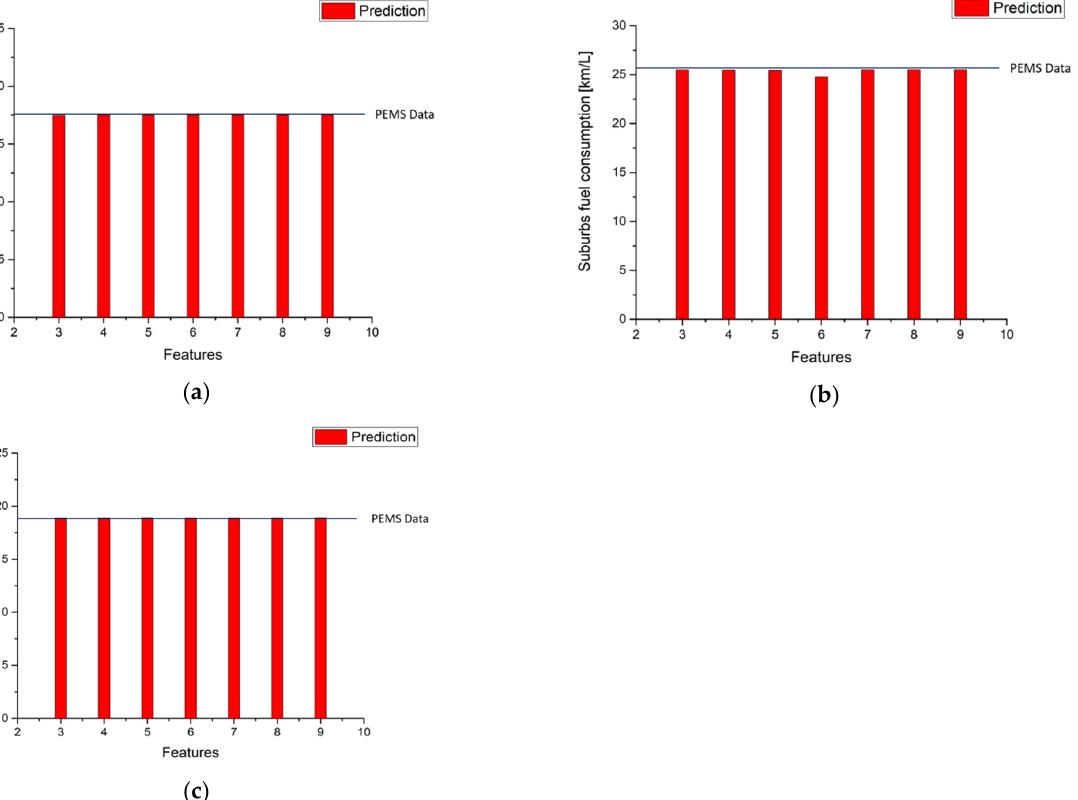
Figure 17. Fuel consumption statistics results in route 1 ( a ) Urban; ( b ) Suburbs; ( c ) Highway.